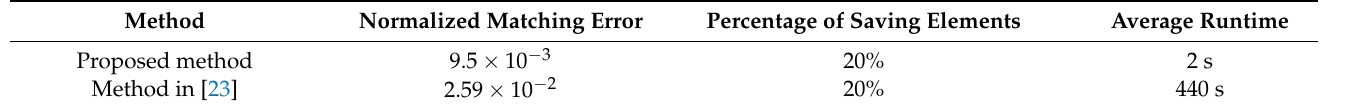
Table 1. The performance comparison of different sparse SFDA synthesis methods.